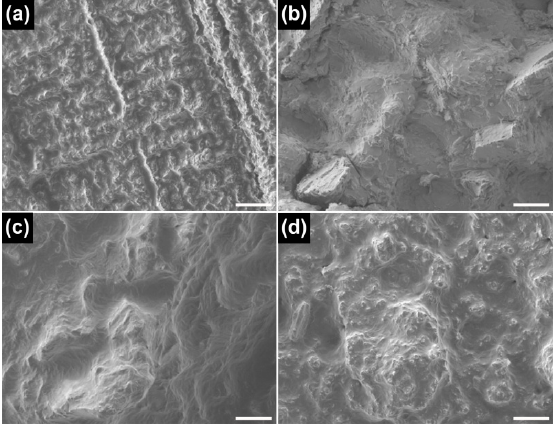
Figure 8. SEM images of the fractured surfaces after tensile test. ( a ) CS; ( b ) ML; ( c ) SLM; and ( d ) ML/PS (500×, scale bar = 30 μ m).